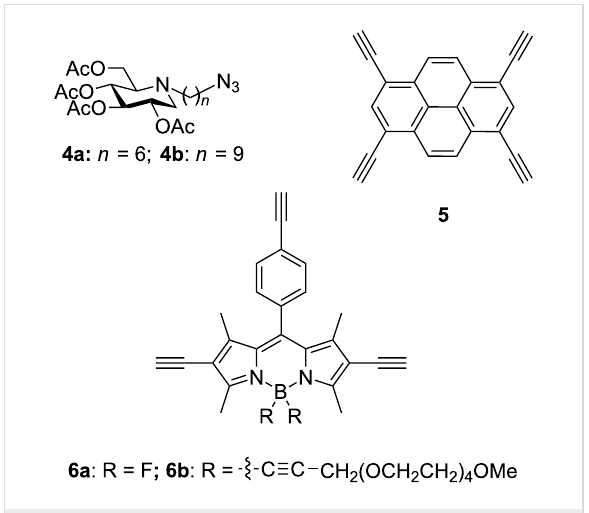
Figure 2: Azide-armed DNJ derivatives 4 and polyalkyne “clickable” scaffolds 5 and 6